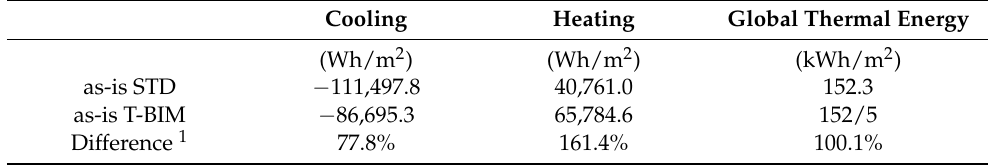
Table 7. Statistical simulation values for the as-is STD and the as-is T-BIM simulated models. Cooling